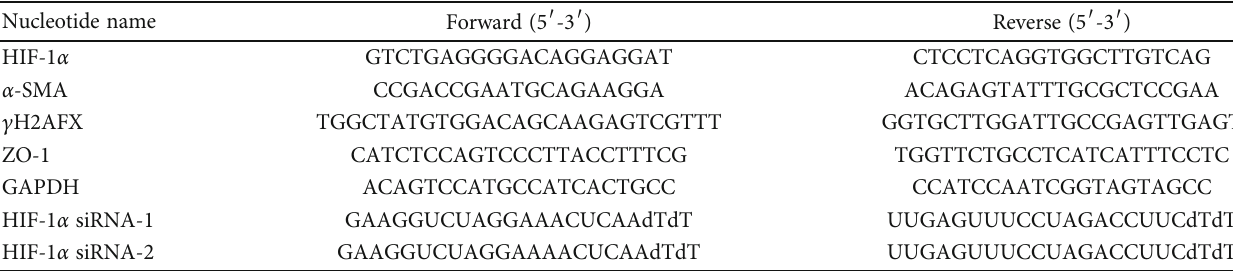
Table 1: Primer and siRNA